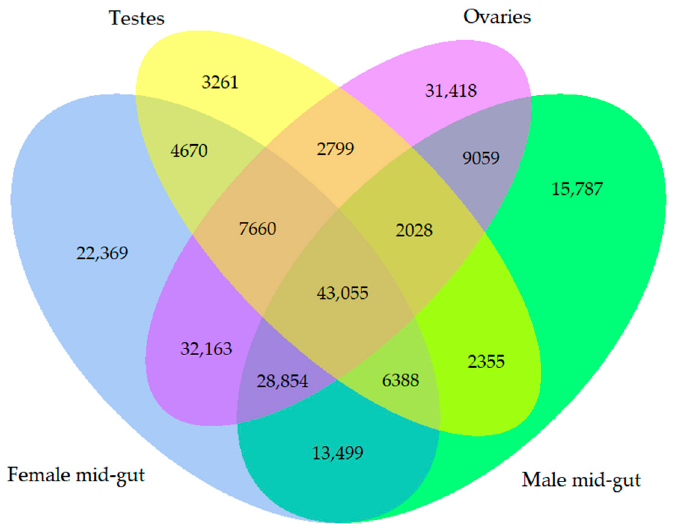
Figure 2. Venn diagram showing the number of overlapping genes among all the libraries of two-spotted field crickets.